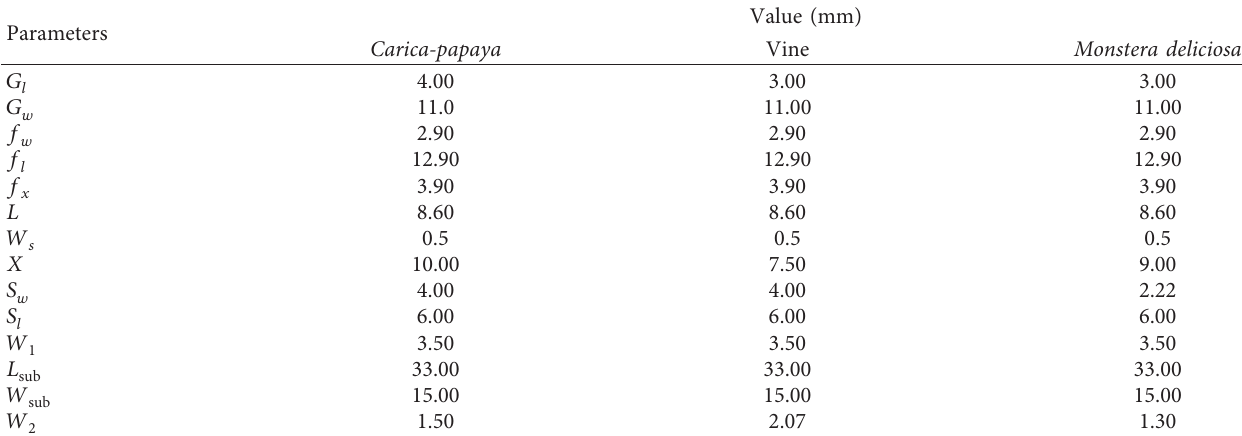
Table 1: Optimized BioAs-MPA Antennas configuration parameters.